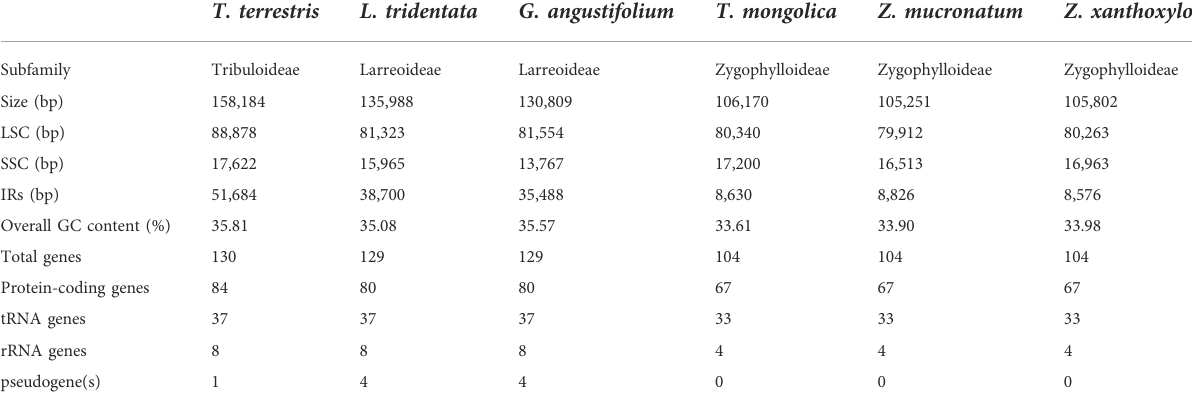
TABLE 4 Summary of the six Zygophyllaceae chloroplast genomes.